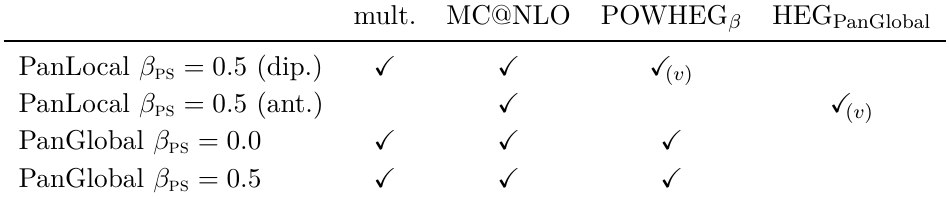
Table 1. The main matching and shower combinations for which we will test NNDL accuracy, for both γ ∗ /Z → q ¯ q and H → gg . A ( v ) next to a check mark indicates that we use the vetoing algorithm of section 3.3. We use the NODS colour scheme from ref.